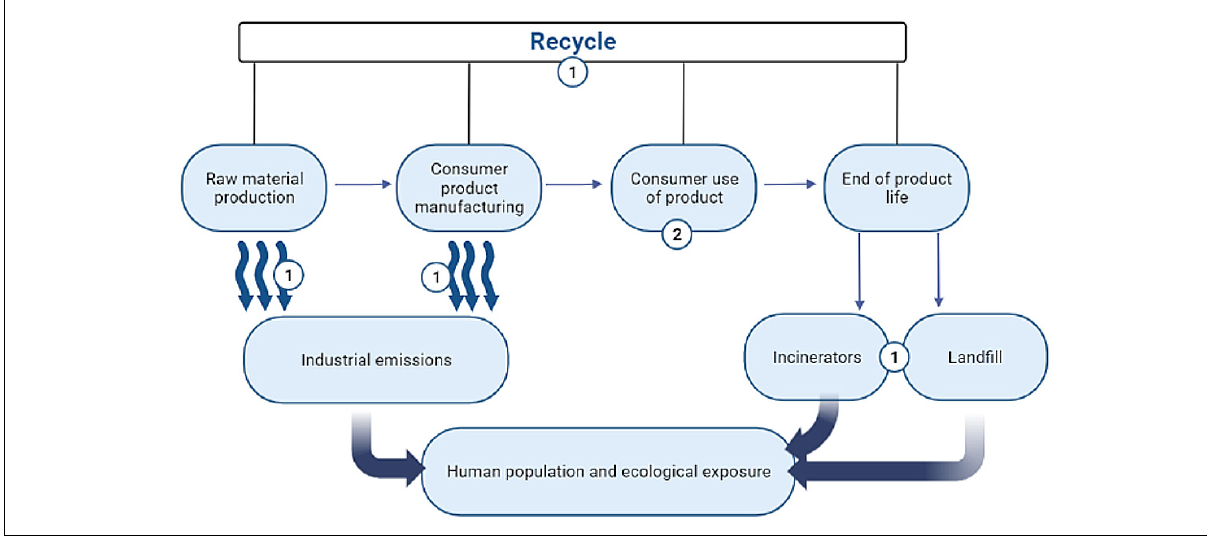
Figure 1: Diagram depicting the human and ecological exposure to nanomaterials during different product lifecycle stages of the materials in environmental, health and safety evaluations (1 = worker exposure, 2 = consumer